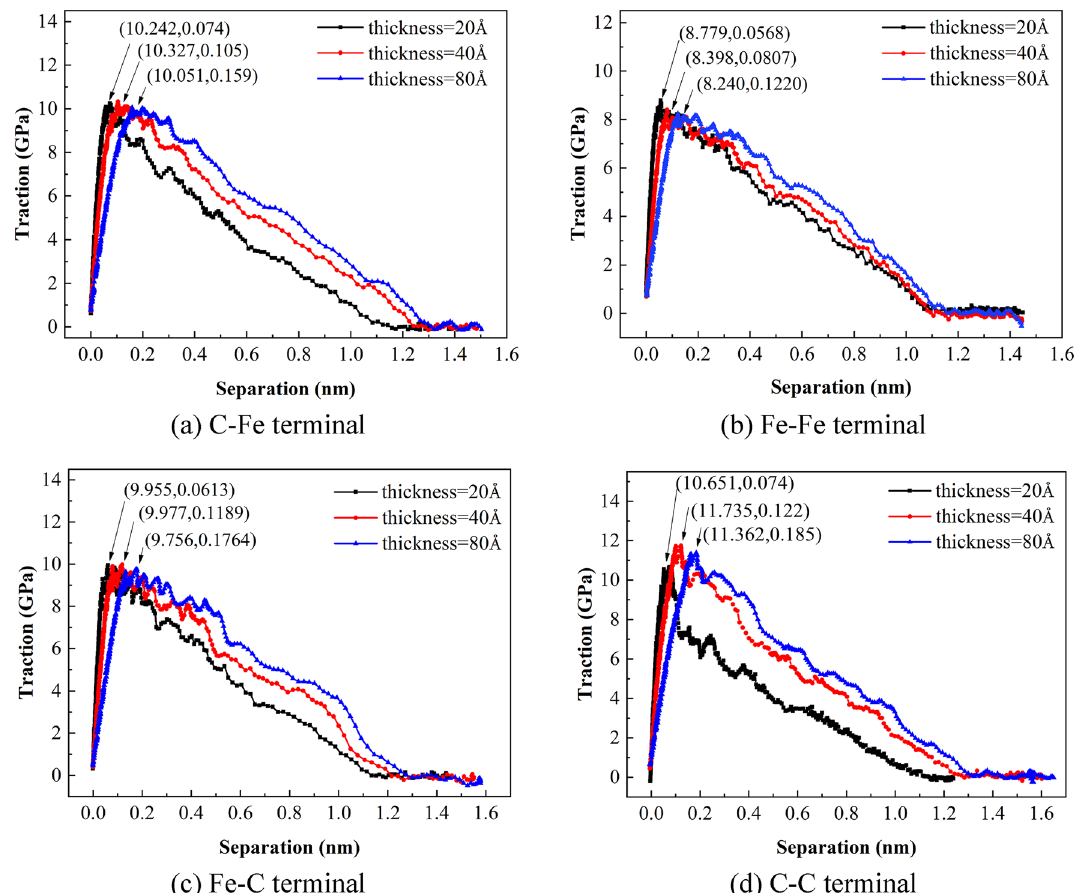
Figure 13. TS curves of different thickness cohesive zones with different terminals.